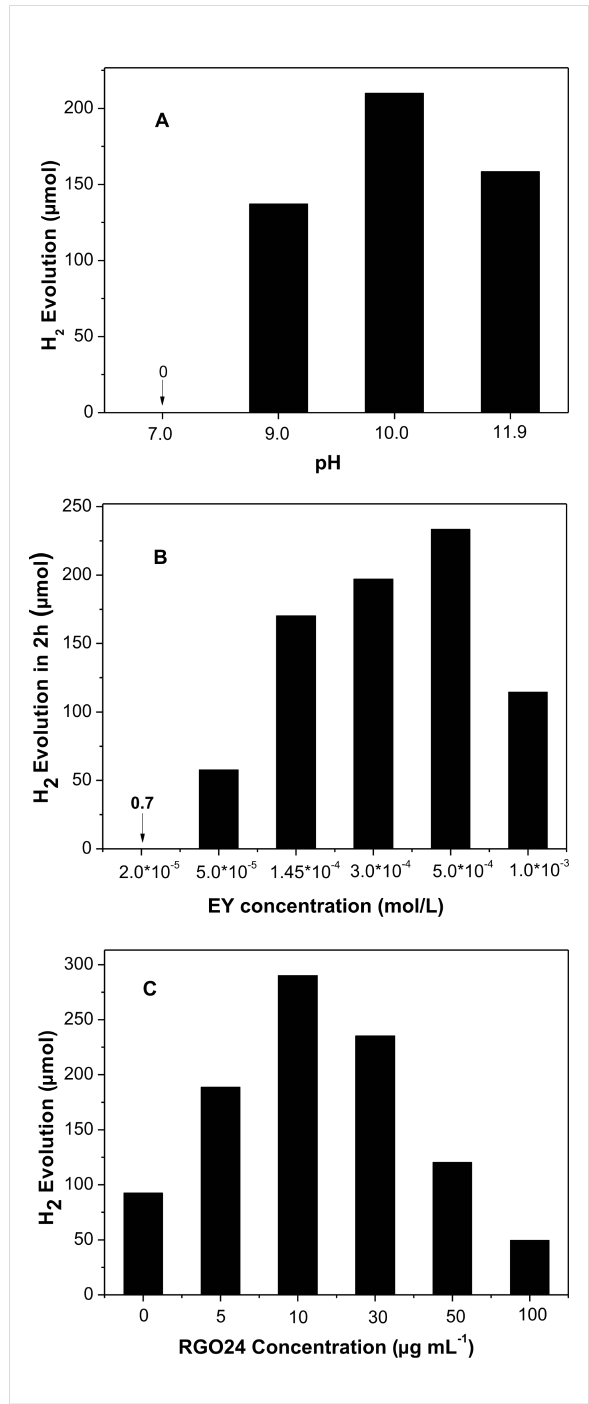
Figure 7: (A) The effect of the pH value on the photocatalytic activity of EY-RGO24/Pt. Conditions: 30 μ g mL − 1 RGO24; 1.45 × 10 − 4 mol L − 1 EY; 4.6 × 10 − 6 mol L − 1 H 2 PtCl 6 ; 7.7 × 10 − 2 mol L − 1 TMA; irradiation 2 h. (B) The effect of the EY concentration on the photocatalytic H 2 evolution over EY-RGO24/Pt. Conditions: 30 μ g mL − 1 RGO24; 4.6 × 10 − 6 mol L − 1 H 2 PtCl 6 ; 7.7 × 10 − 2 mol L − 1 TMA, pH 10.0; irradi- ation 2 h. (C) The effect of the RGO24 concentration on the photocat- alytic H 2 evolution over EY-RGO24/Pt. Conditions: 5.0 × 10 − 4 mol L − 1 EY; 4.6 × 10 − 6 mol L − 1 H 2 PtCl 6 ; 7.7 × 10 − 2 mol L − 1 TMA, pH 10.0; ir- radiation 2